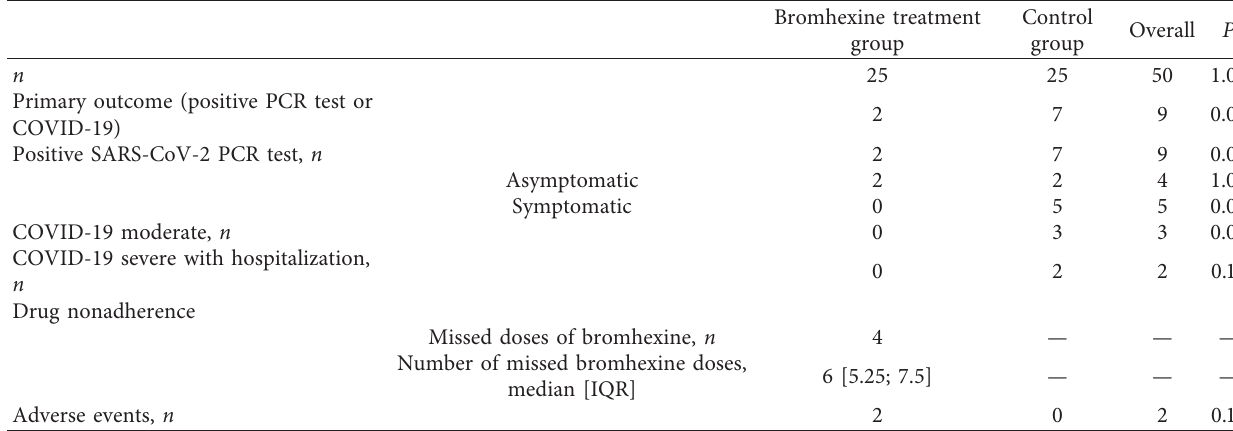
Table 2: Study outcomes: positive PCR tests and